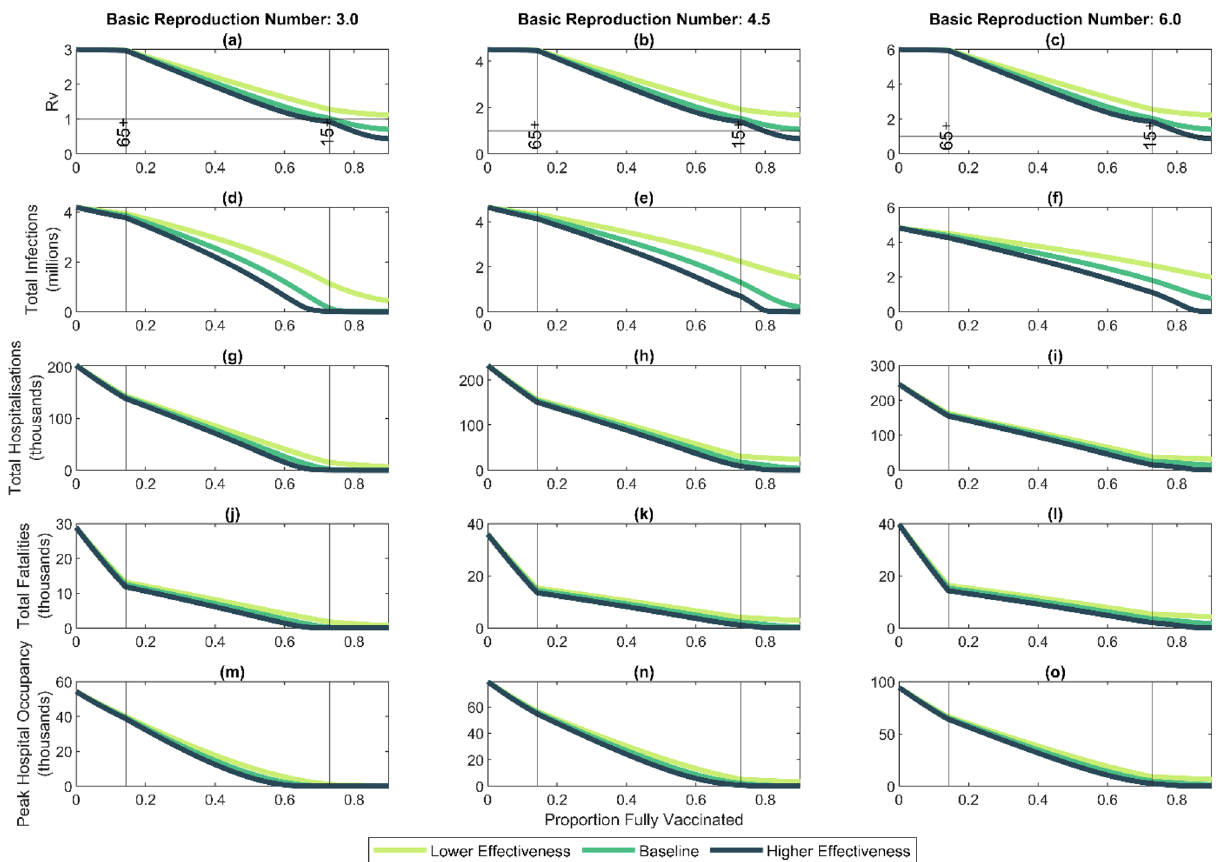
Figure 1. High vaccine coverage greatly reduces potential morbidity and mortality but, for a highly transmissible variant ( R 0 = 6 ), population immunity is unlikely to be achieved via vaccination alone: ( a – c ) effective reproduction number R v after vaccination; ( d – f ) total infections; ( g – i ) total hospitalisation; ( j – l ) total fatalities; ( m – o ) peak hospital occupancy for an unmitigated epidemic over a two-year period as a function of total vaccine courses administered, assuming there is no further vaccination after the outbreak begins. Results are shown for three values of the basic reproduction number: R 0 = 3.0 , R 0 = 4.5 , R 0 = 6.0 . Along the horizontal axis, the roll-out begins in the 65 + year-old age group; once 90% of the 65 + year old group is vaccinated (left-hand vertical line), vaccination of the 15–64-year-old group begins; once 90% of the